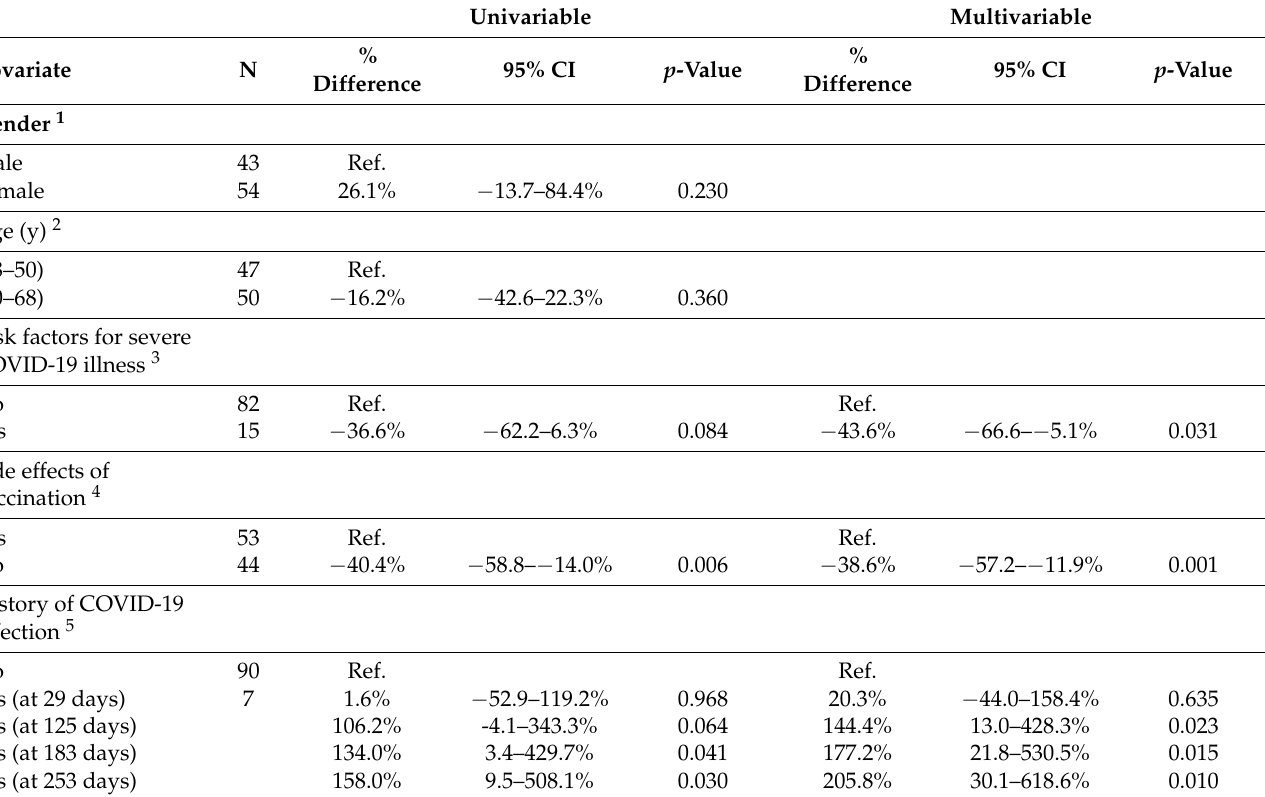
Table 4. Relative differences in means of anti-SARS CoV-2 RBD IgG levels by gender, age, risk factors for severe COVID-19 illness, side effects of vaccination, and history of previous COVID-19 infection in the BNT162b2 post-vaccination period. Results based on univariable and multivariable analysis based on mixed models including restricted cubic spline time